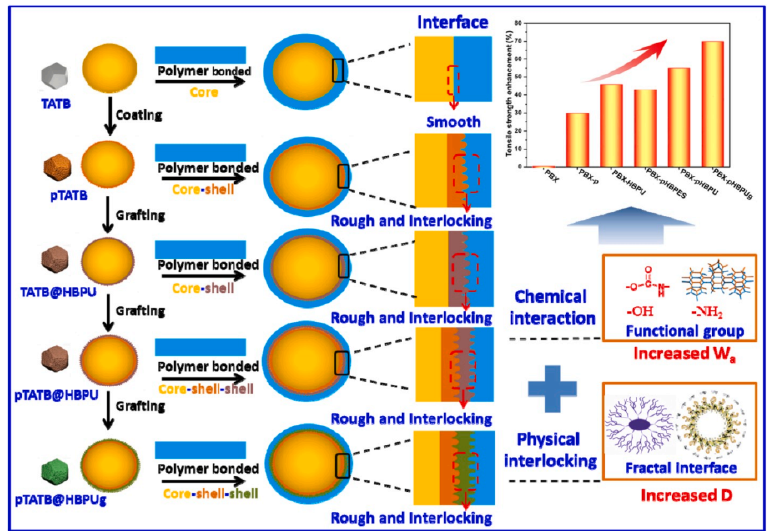
Figure 9. Schematic representation of the interfacial interactions in TATB-based PBX composites. Reproduced with permission from [55], copyright 2020, Elsevier.